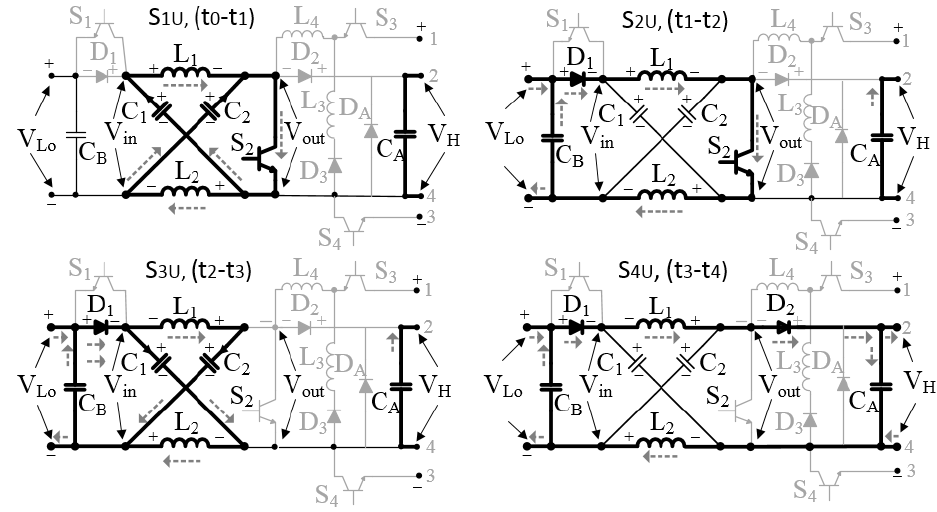
Figure 1. Circuits of the different stages of the converter.